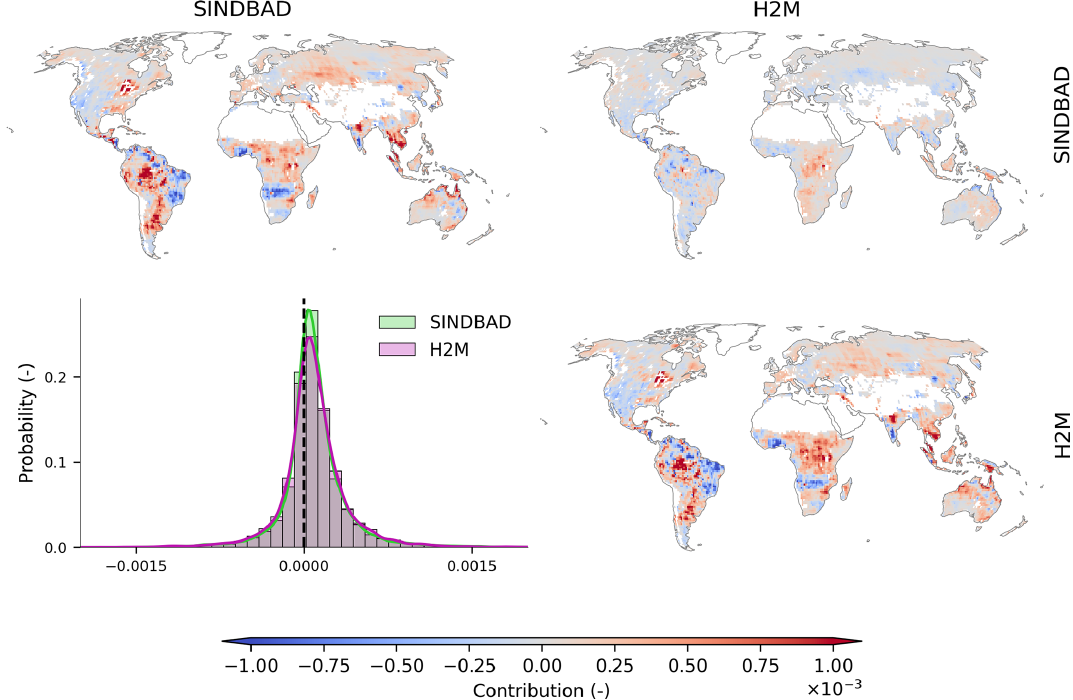
Figure B21. Same as Fig. 4 but using MSWEP instead of GPCP1dd for the precipitation forcing.